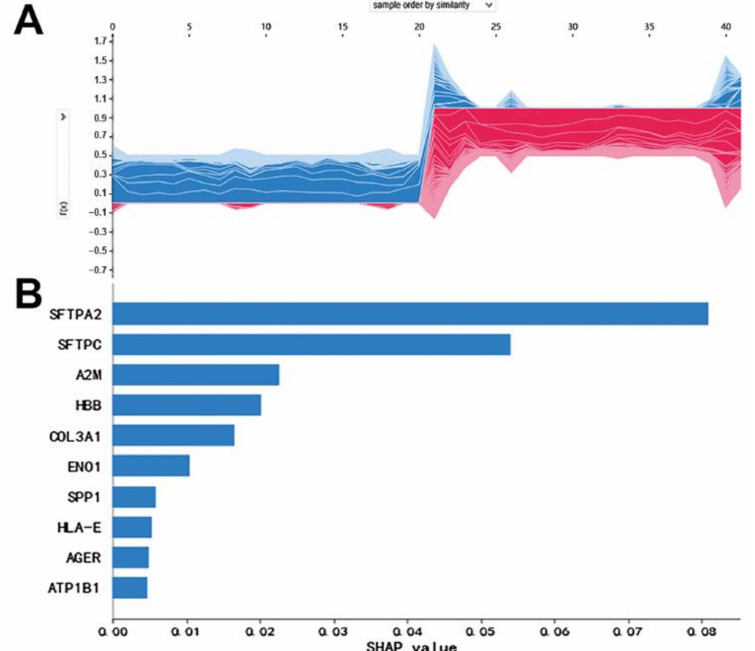
Figure 3. The SHAP values of the mRNAs: ( A ) Contribution of each mRNA to partial individual sample. Red represents the positive influence, and blue represents the negative influence. The abscissa represents the samples, and the ordinate represents the SHAP values. ( B ) The SHAP values of top 10 mRNAs based on their contribution to all